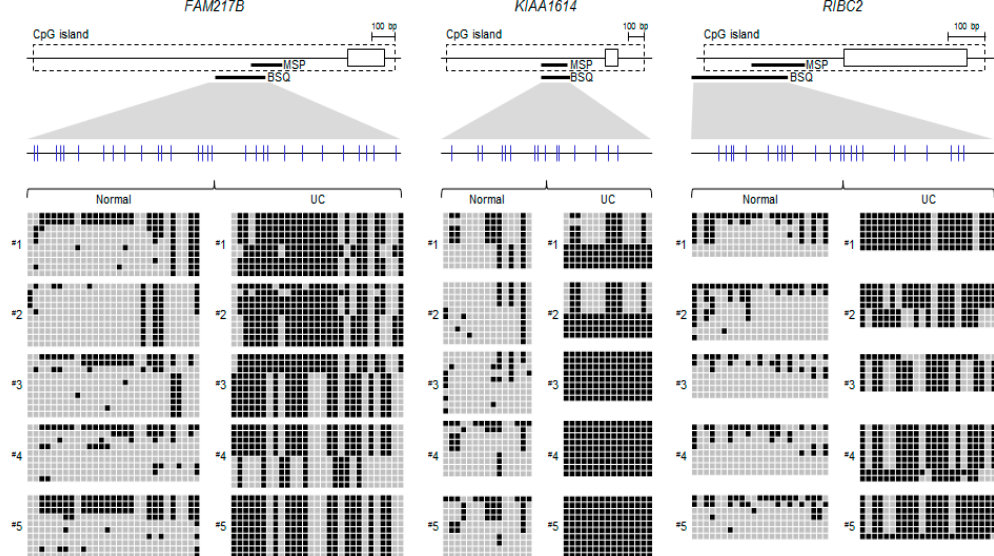
Figure 3. Bisulfite sequencing analyses of the CpG island in FAM217B , KIA1614 , and RIBC2 gene promoter regions. A schematic representation of each gene CpG island (box). The regions analyzed using methylation-specific PCR (MSP) and bisulfite sequencing are indicated by black bars below the CpG island. Individual CpG sites are indicated as vertical lines. Representative bisulfite sequencing analyses were performed for all three genes in representative UC patient samples ( n = 5) and controls ( n = 5). Each box represents a CpG dinucleotide. Black boxes represent methylated cytosines and gray boxes represent unmethylated cytosines.